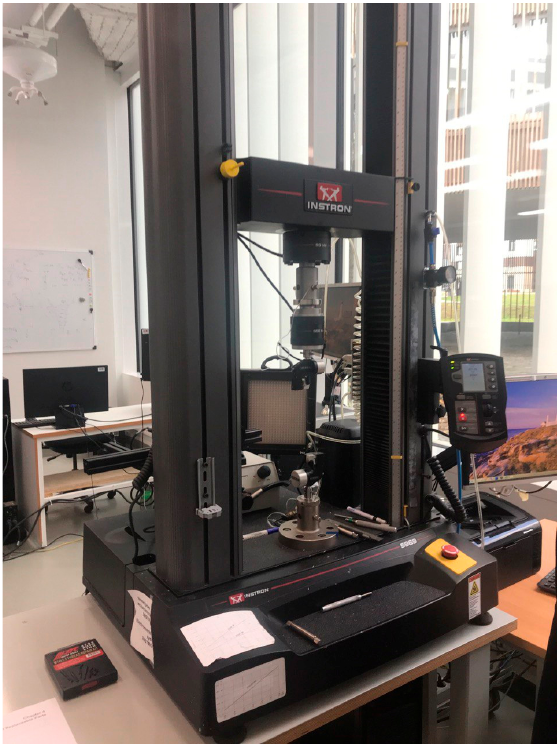
Figure 2. Instron 5969 Dual Column Testing System with material Glycolon in